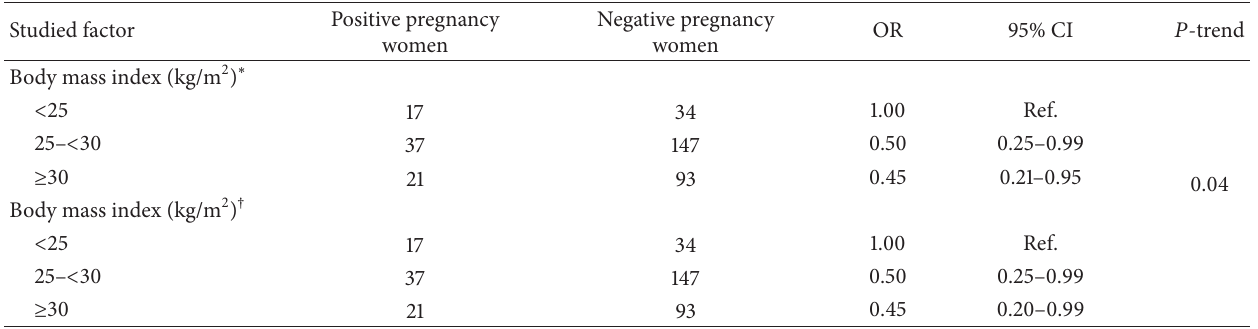
Table 2: Odds ratios (OR) and their 95% confidence intervals (CI) for the association of BMI with positive pregnancy outcome. Studied factor